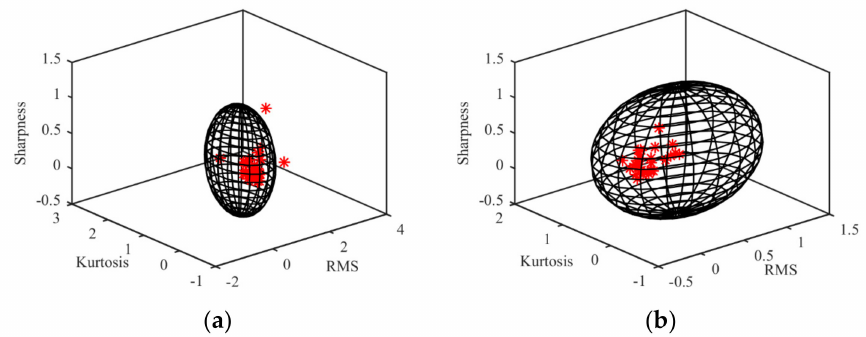
Figure 15. Flywheel #4 test noise sample point and security domain: ( a ) 3000 r / min; ( b ) 4600 r /